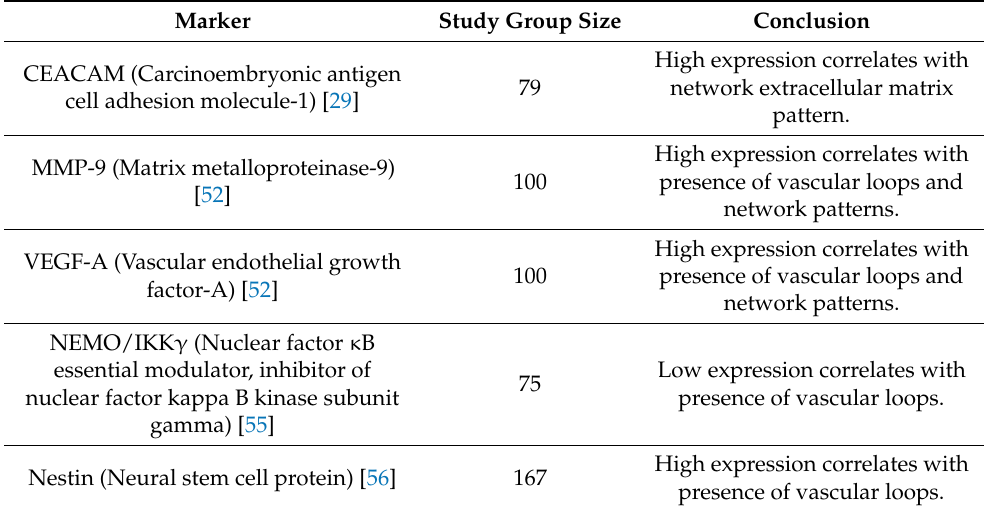
Table 8. Summary of markers whose expression is related to extravascular matrix loops and networks. Marker Study Group Size